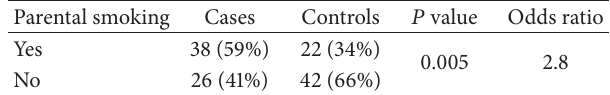
Table 2: Exposure to parental